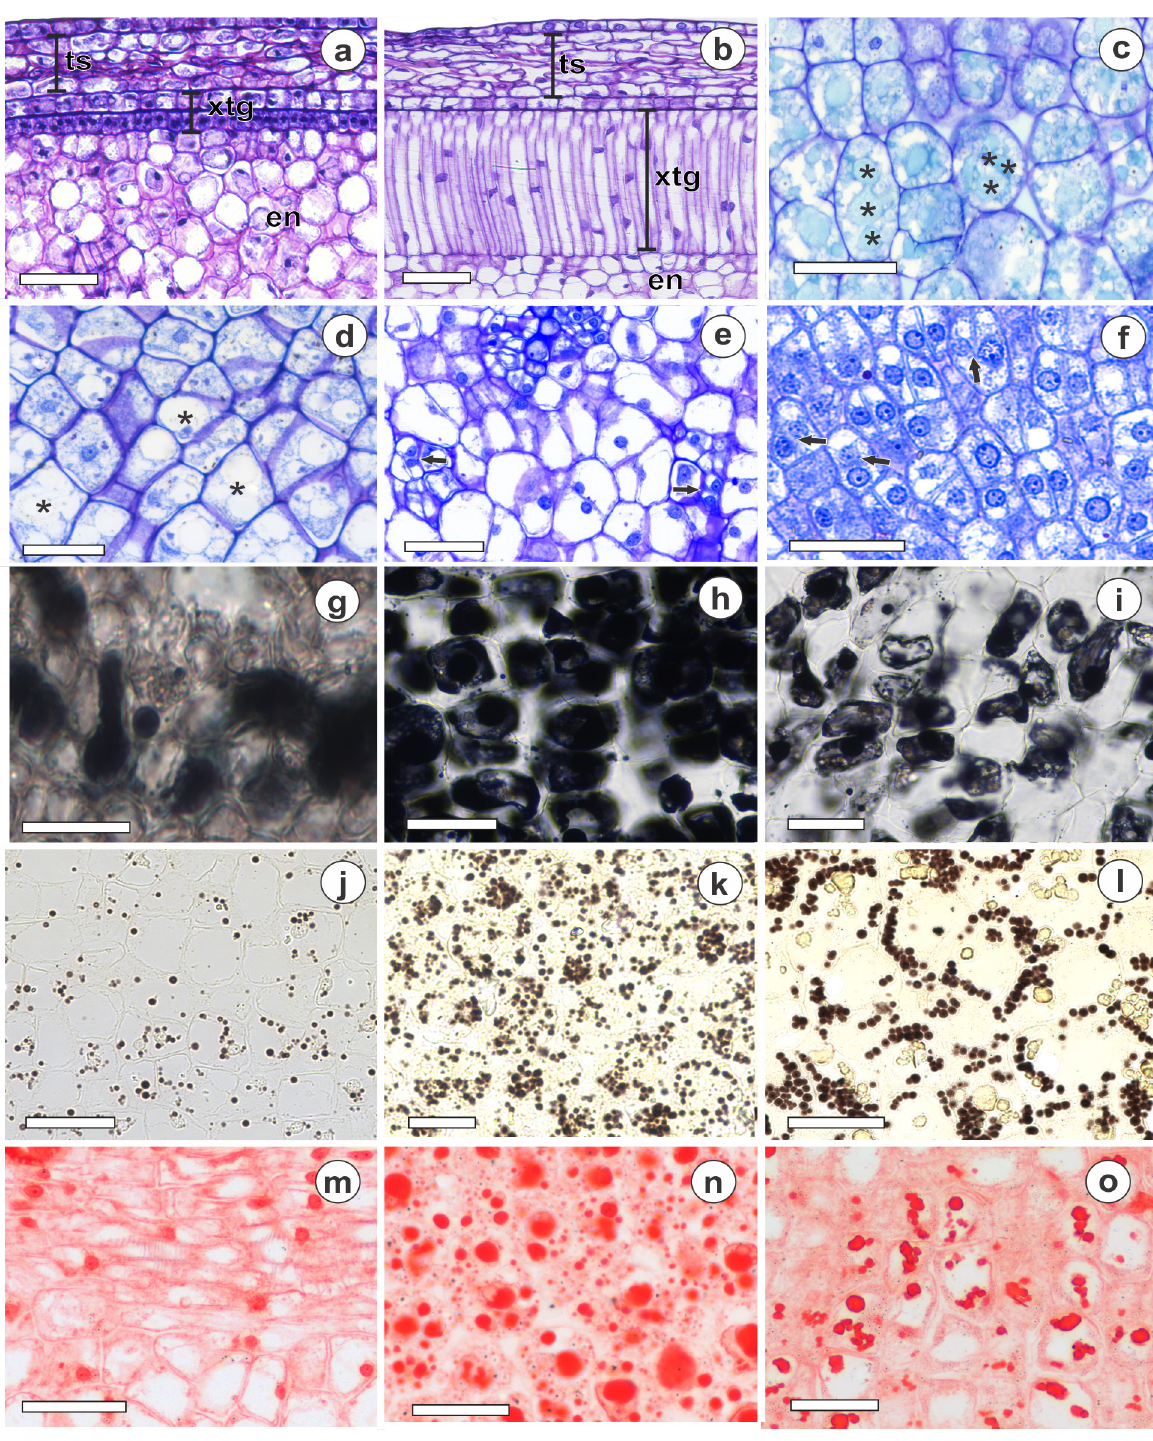
Figure 5 - Transversal section of Hevea brasiliensis L. seeds during development. Seed with 60 DAA ( a ), with 90 DAA ( b ); endosperm with 150 DAA ( c ), 175 DAA ( d ), 175 DAA ( e ); Embryonic axis with 175 DAA ( f ); for lipids content: endosperm with 150 DAA ( g ), with 165 DAA ( h ) and with 175 DAA ( i ); for starch content: endosperm with 150 DAA ( j ), 165 DAA ( k ) and 1750 DAA ( l ) and for protein content: 150 DAA ( m ), 165 DAA ( n ) and 175 DAA ( o ). en, endosperm; xtg, exotegmen, ts, testa = evidence of cell division. Bars = 50 μ